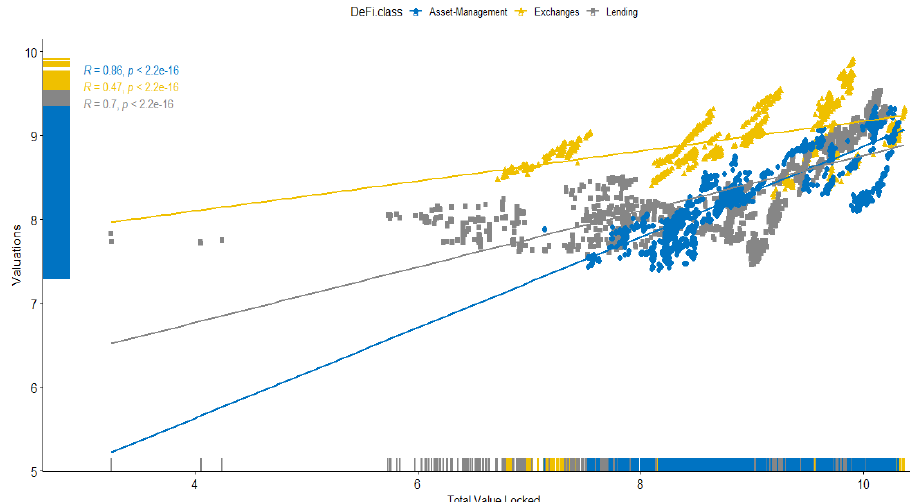
Figure 3. Correlations between Valuations and TVLs for 3 different DeFi classes’ protocols. Note: All data logarithmized. Source: own elaboration in R-Studio.